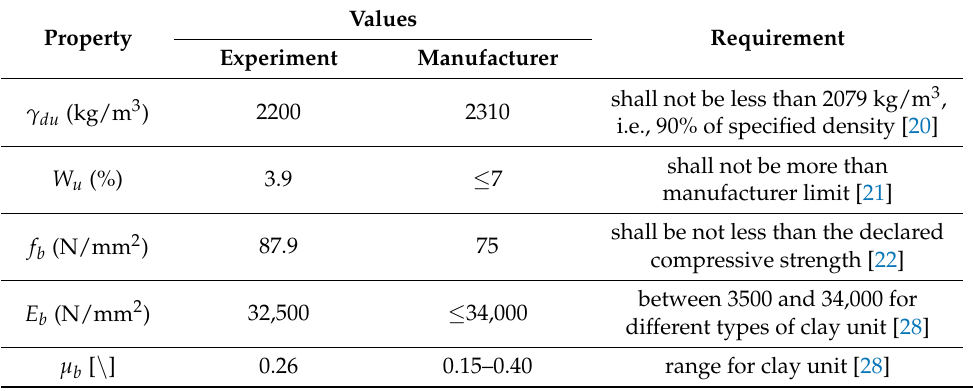
Table 2. Experimental results on properties of brick units vs. manufacturer’s specification.